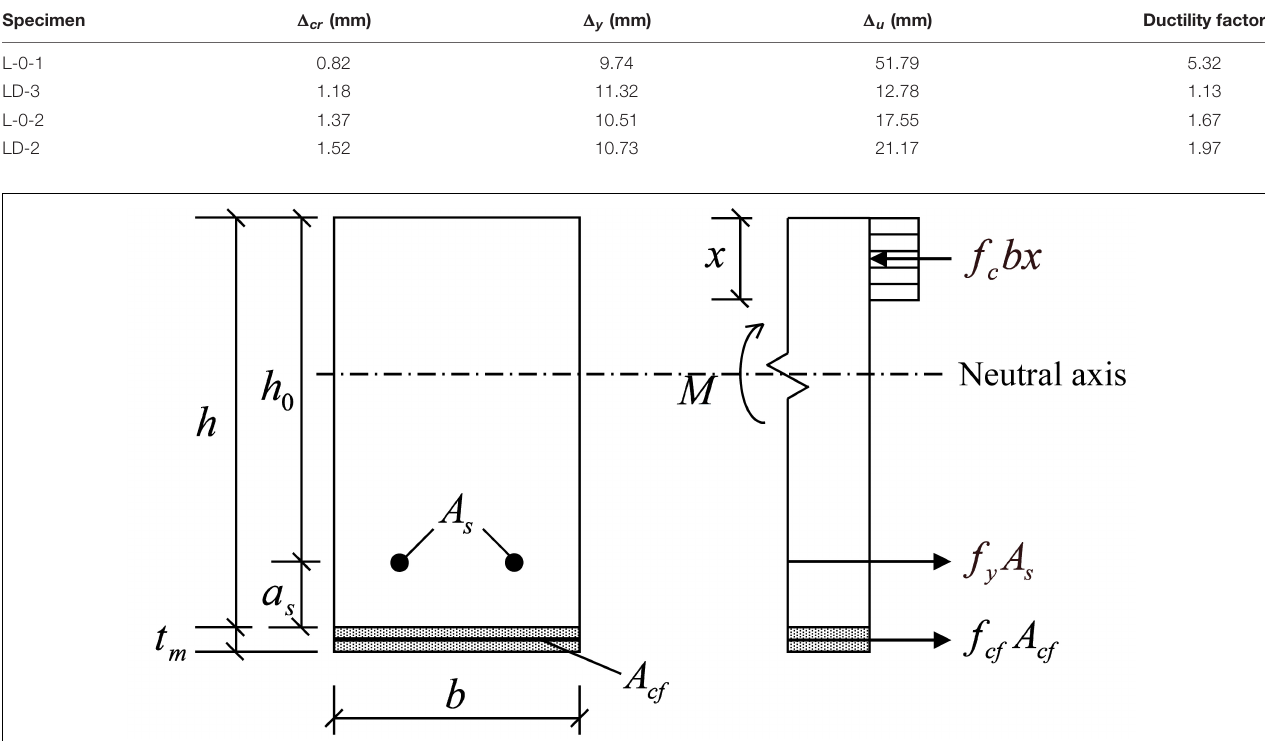
TABLE 5 | Deflections and ductility factor of specimens.